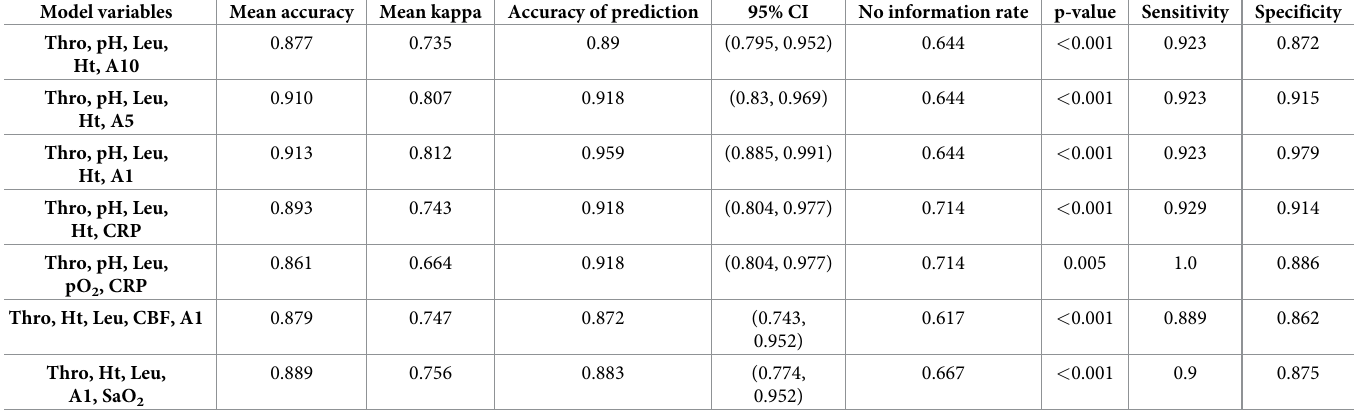
Table 6. Performance results for extremely preterm